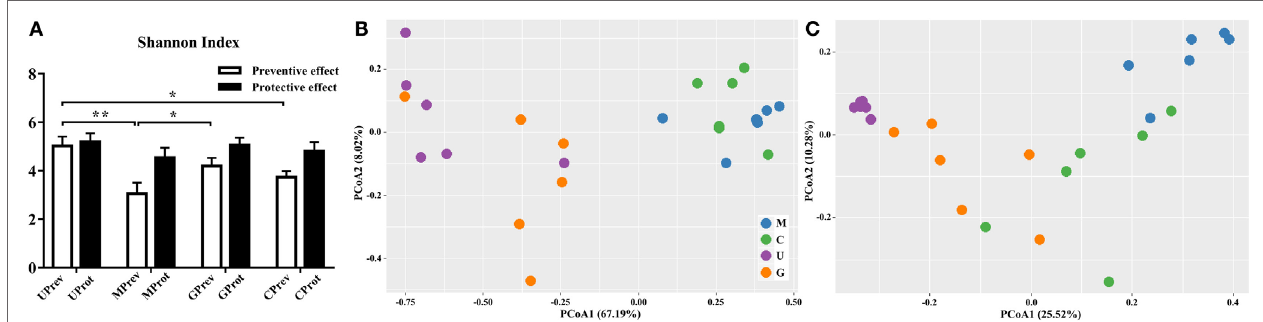
FigUre 4 | Diversity of the gut microbiota. (a) Alpha diversity of the gut microbiota of U, M, G, and C mice as measured by the Shannon index and (B,c) beta diversity analyzed using principal components analysis (PCoA) score plots based on weighted UniFrac metrics for the gut microbiota from the eight treatment groups of mice: (B) samples taken 1 day after the administration of CCl 4 (to determine preventive effects of milk consumption on induced liver injury) from untreated control mice (UPrev), model mice (MPrev), mice receiving goats’ milk (GPrev), and mice receiving cows’ milk (CPrev) and (c) samples taken 8 days after administration of CCl 4 (to determine protective effects of continued milk consumption on induced liver injury) from untreated control mice (UProt), model mice (MProt), mice receiving goats’ milk (GProt), and mice receiving cows’ milk (CProt). The data and error bars are presented as mean ± SEM. * P < 0.05; ** P <